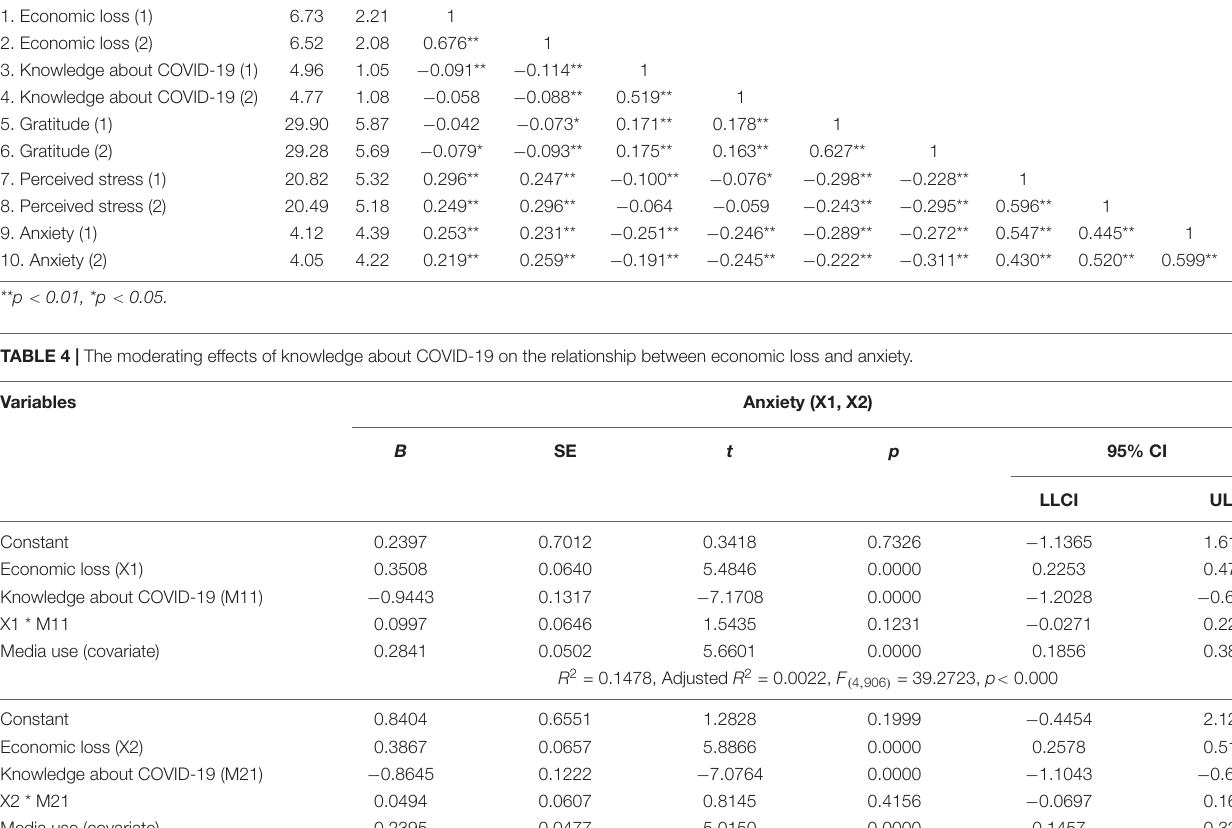
TABLE 3 | The means, standard deviations, and correlation coefficients of the variables included in the moderation models. M SD